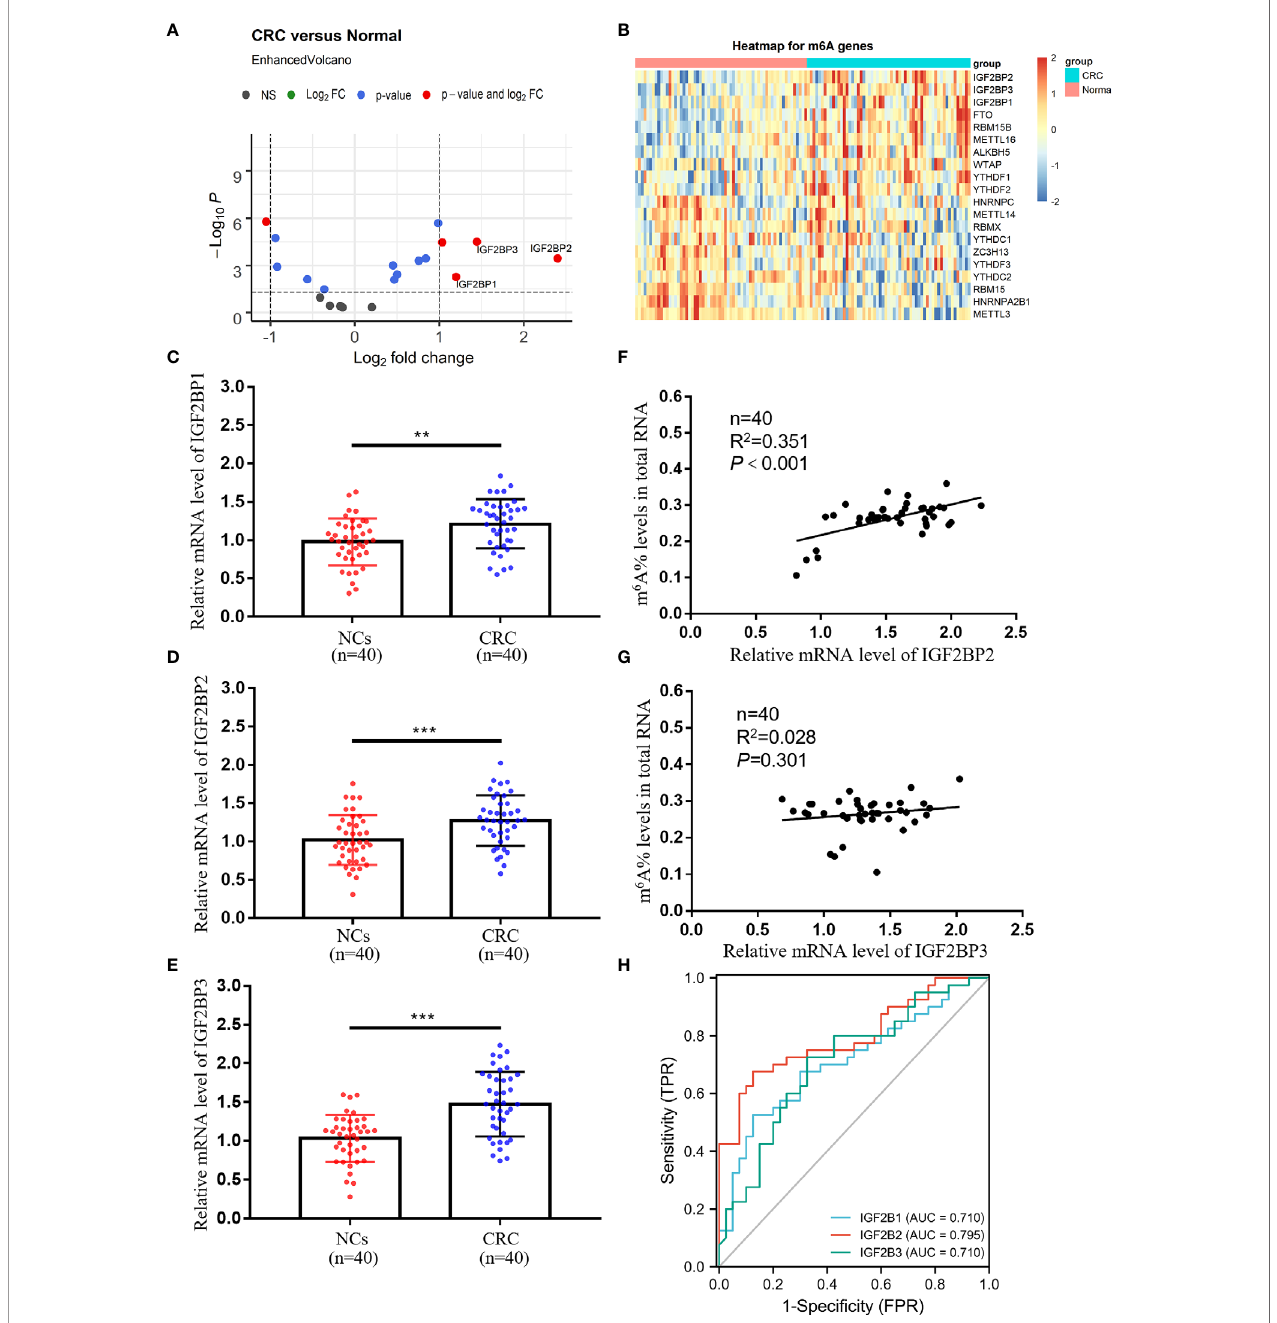
FIGURE 3 | Expressions and diagnostic values of IGF2BP1, IGF2BP2, and IGF2BP3 in peripheral blood immune cells of CRC patients. (A) Screening key molecules related to m 6 A modi fi cation in peripheral blood of CRC patients ( n = 59) compared to normal subjects ( n = 62) by limma differential analysis. (B) Heatmap of key molecules related to m6A modi fi cation in peripheral blood of CRC patients. (C – E) qRT-PCR analysis of IGF2BP1 (C) , IGF2BP2 (D) , and IGF2BP3 (E) mRNA expression levels in peripheral blood of NCs and CRC patients. (F, G) Correlation between the levels of IGF2BP2/IGF2BP3 and m 6 A in peripheral blood of CRC patients. (H) ROC curves of the IGF2BP1, IGF2BP2, and IGF2BP3 mRNA expression levels in peripheral blood of CRC patients. Bars represent the mean ± SD of the results from replicate measurements; ** p < 0.01, *** p <